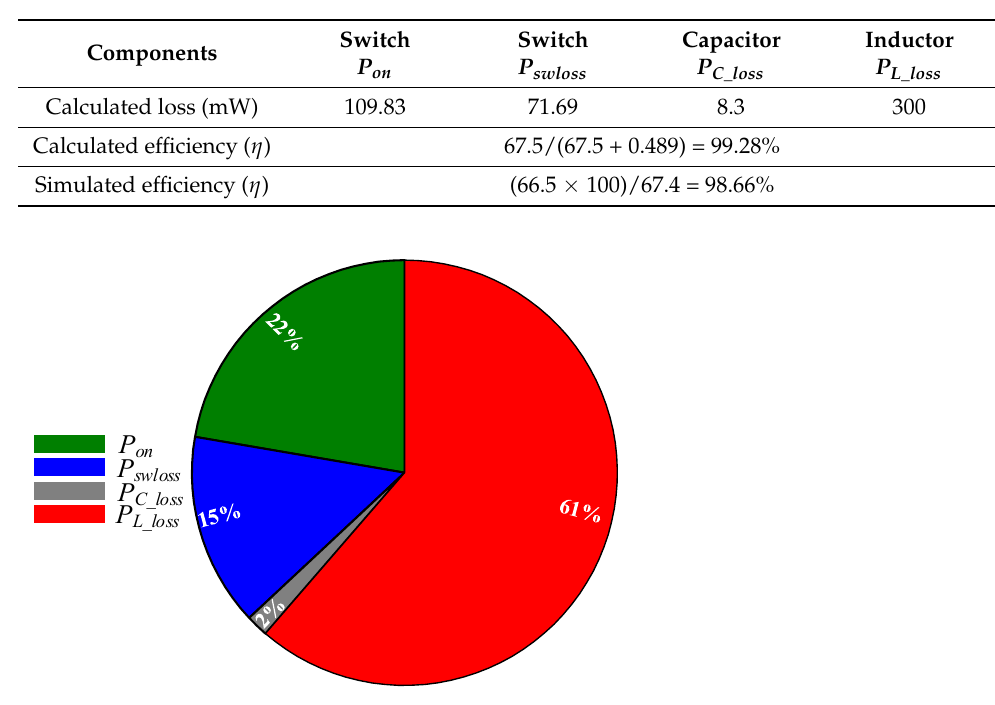
Table 6. Theoretical losses for the SCL -based proposed technique across each component when one PV module is half shaded.